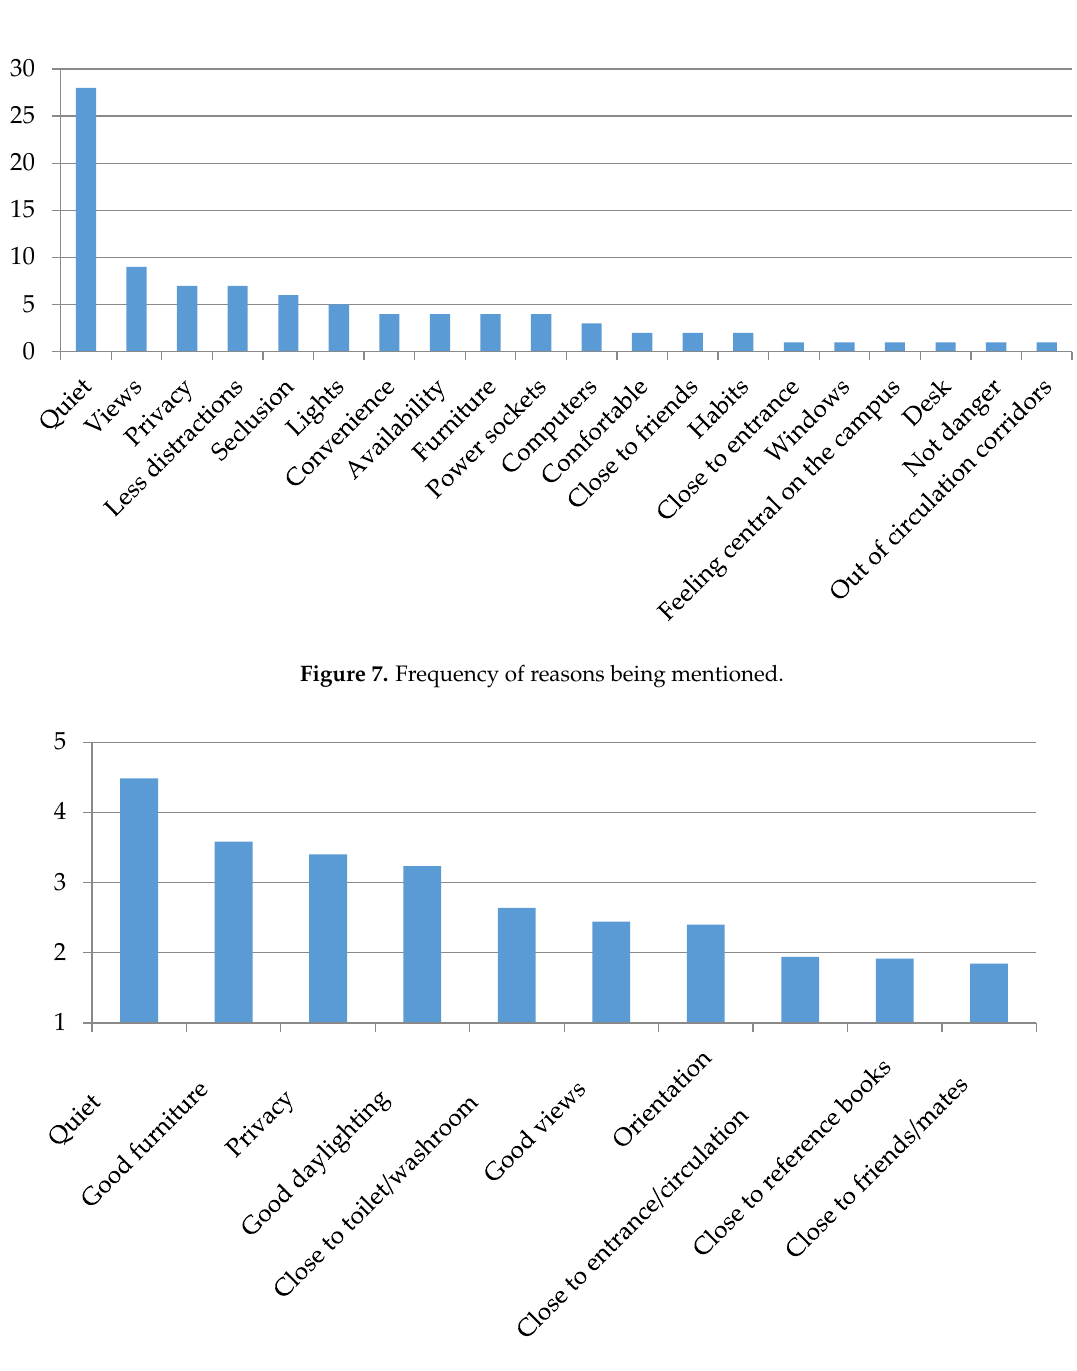
Figure 8. Importance of factors for choosing seats in library.